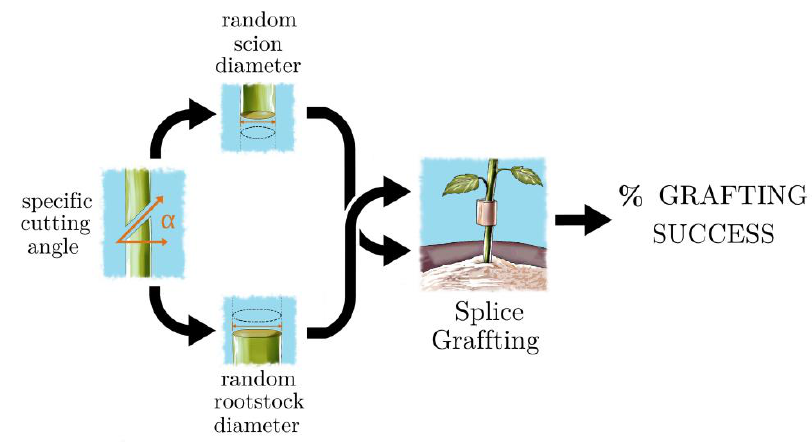
Figure 1. Working procedure of the experimental study to determine the combined importance of random rootstock and scion diameters at different cutting angles on splice grafting success.